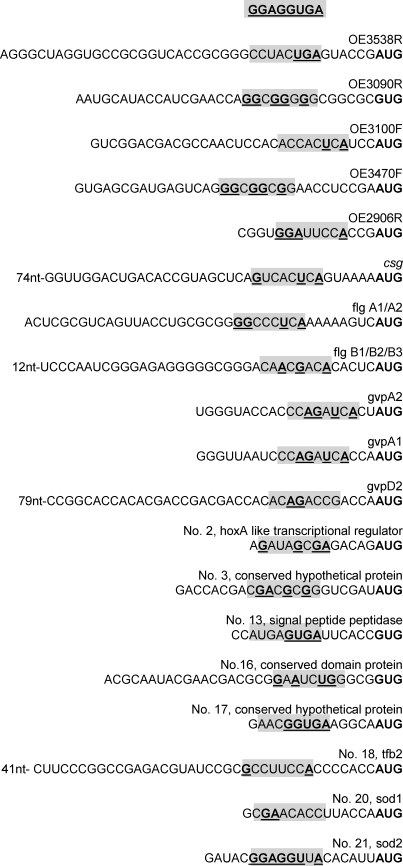
5′-UTRs of Leadered Transcripts of H. salinarum and H. volcani
The sequences of the 5′-UTRs including the translation initiation codon of all leadered transcripts are shown (Tables 1 and 2). The sequence of eight nucleotides complementary to the 3′-end of the 16S rRNA is shown on top of the figure. In E. coli the optimal distance between the 3′-edge of the SD sequence and the A of the start codon is 5 nt and 85% of all genes have distances between 3 and 7 nt (both included) [54]. Because the optimal distance in haloarchaea is not known, the region that fits best to the complementary region was searched allowing distances between 2 and 10 nt. The best matching region is shaded, and the nucleotides that could base-pair with the 16S rRNA are shown in bold and are underlined. The translational start codons are shown in bold.